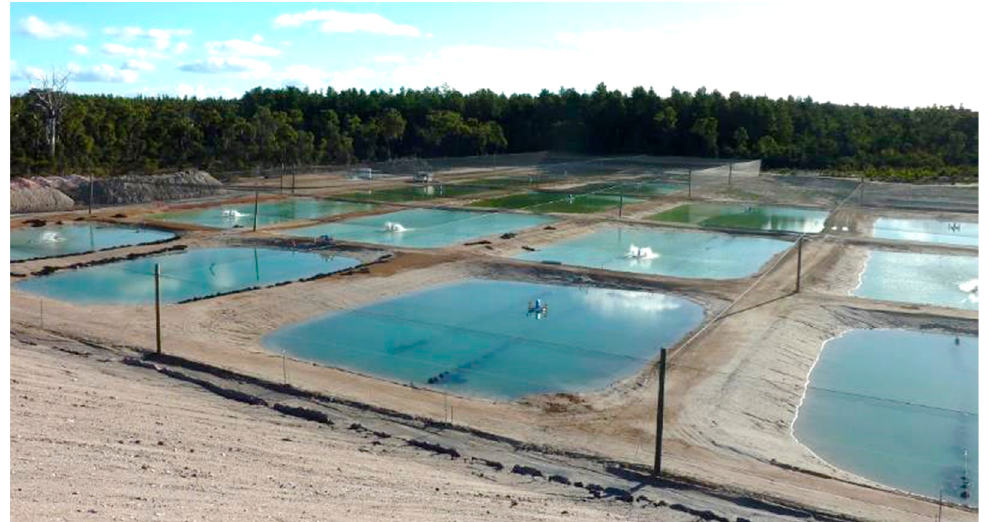
Figure 9. Nutrient-rich discharge to a dystrophic Western Australian coal pit lake from an adjacent aquaculture farm has been found to improve water quality.